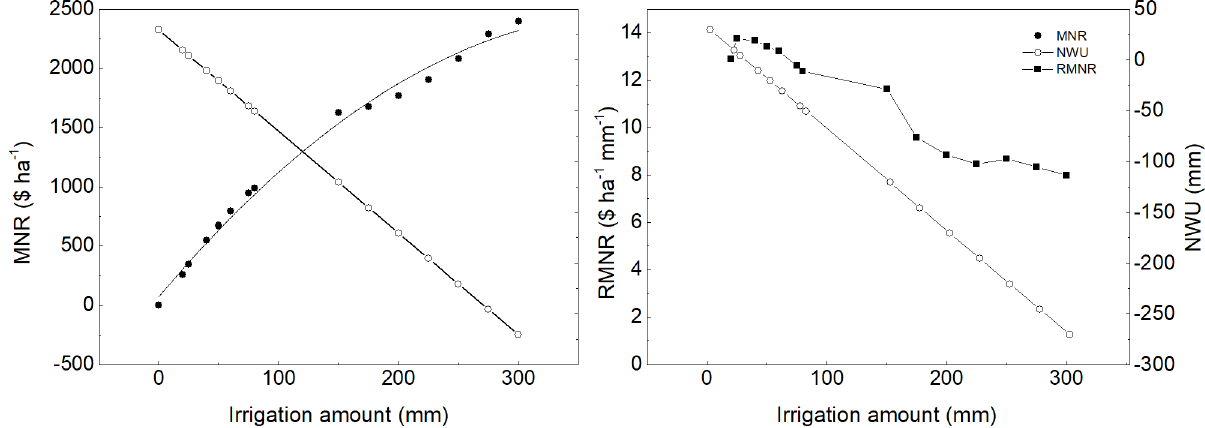
Fig 7. Simulated marginal net return (MNR), relative marginal net return (RMNR) and net water use (NWU) for different irrigation over 22 year seasons.